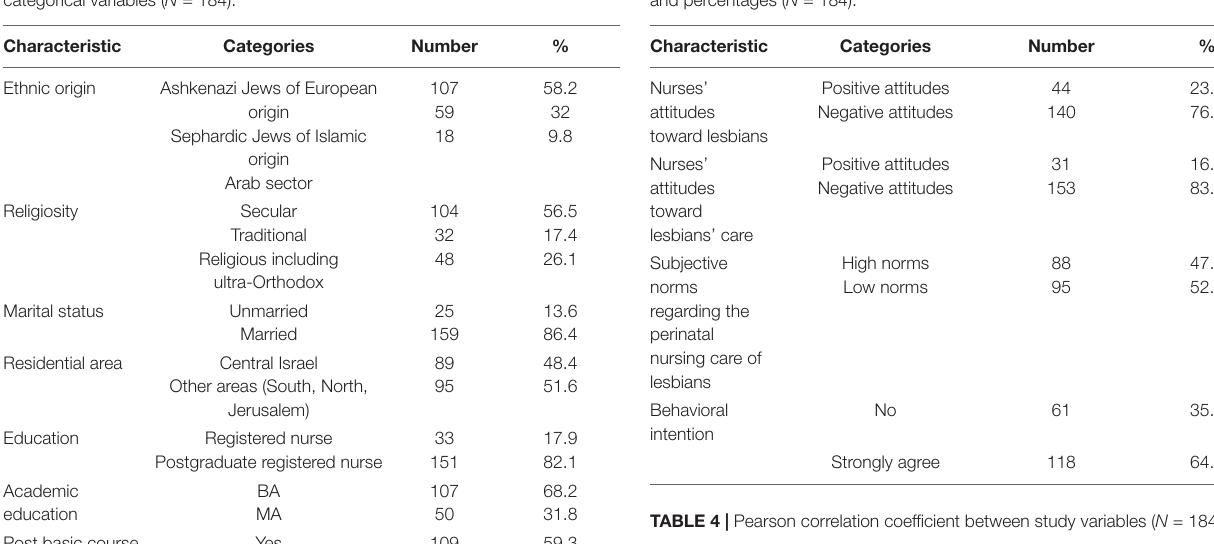
TABLE 3 | Attitudes, subjective norms, and nurses’ behavior intention-frequencies and percentages ( N = 184).